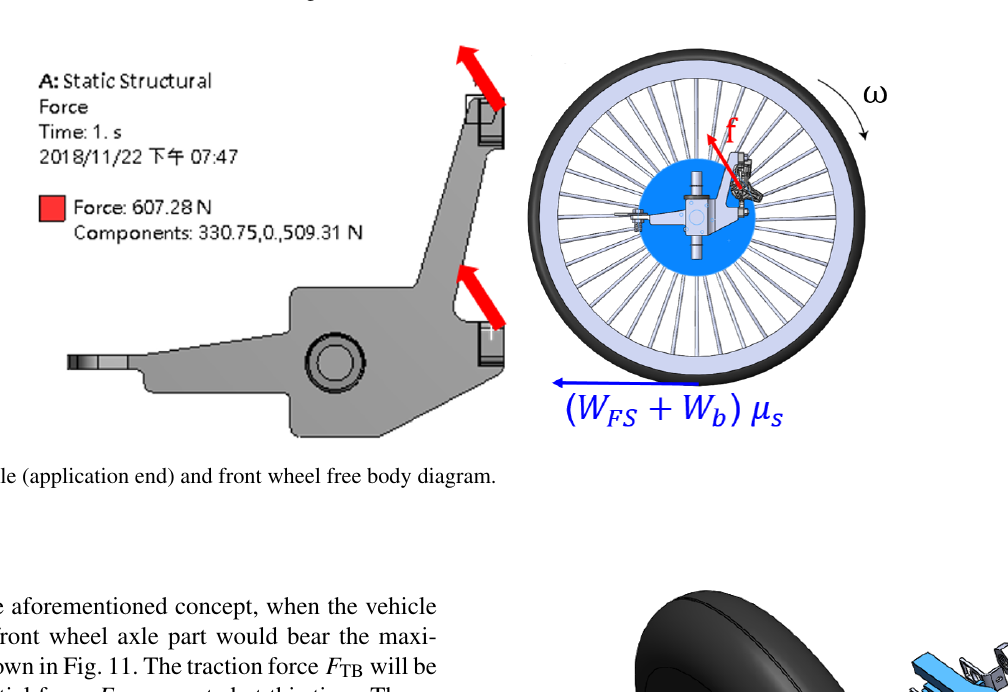
Figure 13. Exploded view of the front wheel steering and knuckle (restrained end).